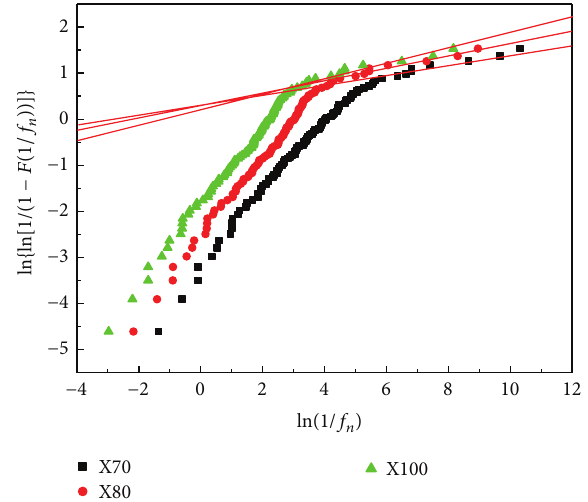
Figure 10: Weibull probability plots of X70, X80, and X100 pipeline steel passive